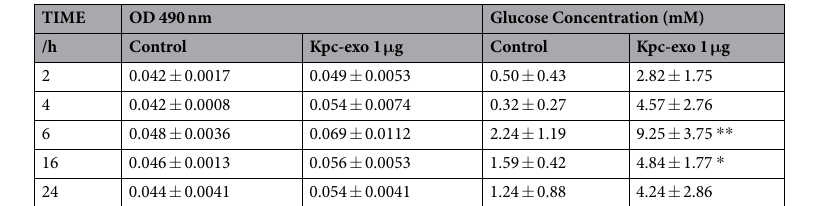
TIME OD 490 nm Glucose Concentration (mM)